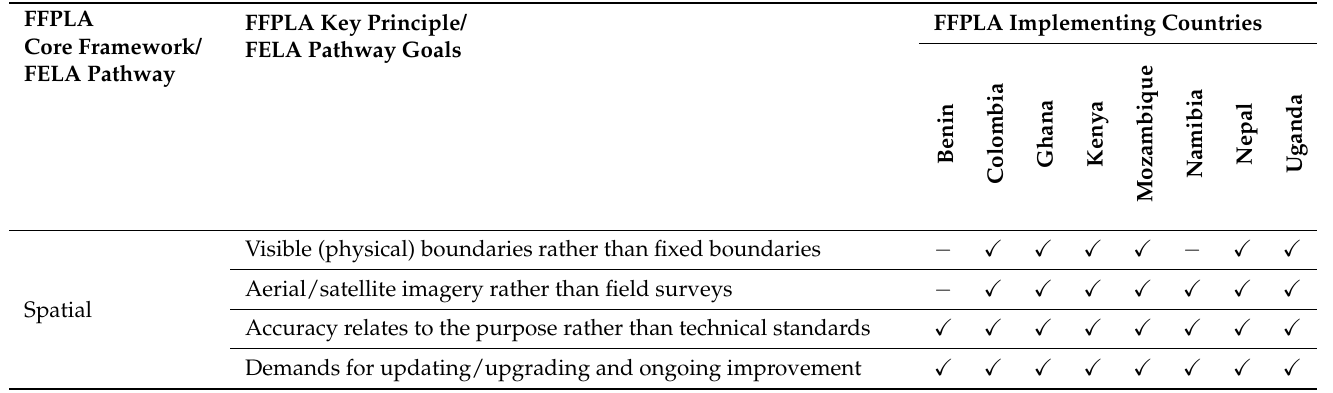
Table 7. FFPLA and FELA implementation checklist based on